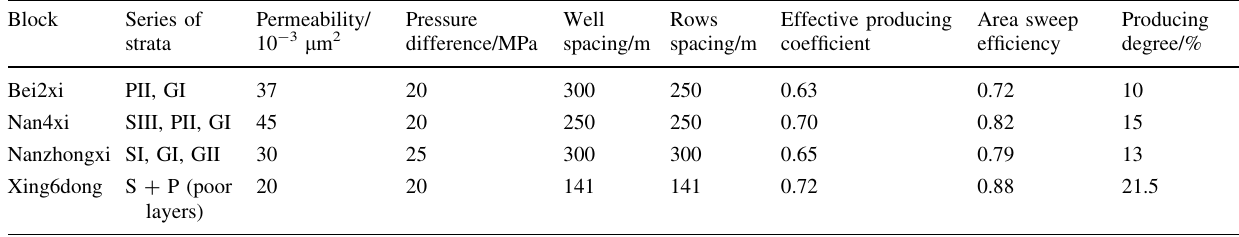
Table 2 Effective producing coefficient and area sweep efficiency for several thin and poor Blocks Block Series of